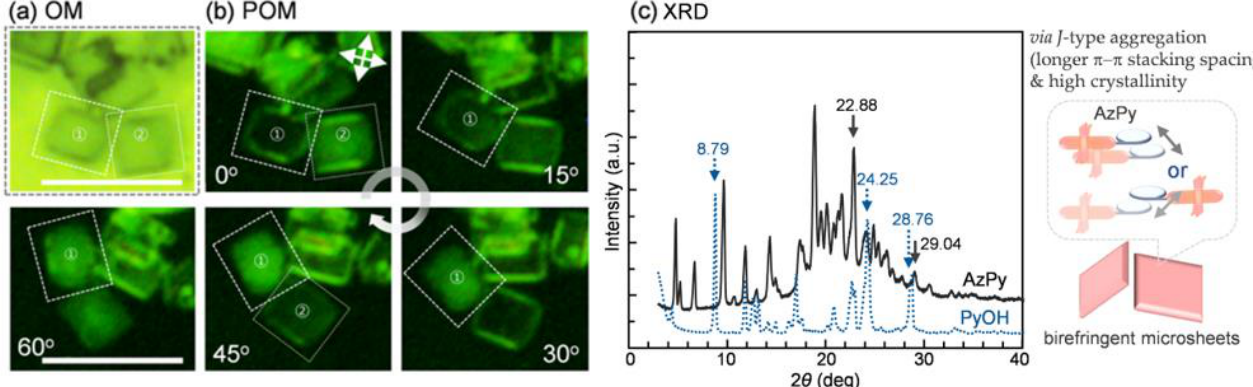
Figure 6. ( a ) OM and corresponding ( b ) POM images of birefringent anisotropic microsheets placed between the crossed polarizers. The sample was rotated by 15 degrees with respect to the crossed polarizers. Scale bar: 10 µ m. ( c ) Powder X-ray diffraction (PXRD) patterns of AzPy and PyOH solid samples.